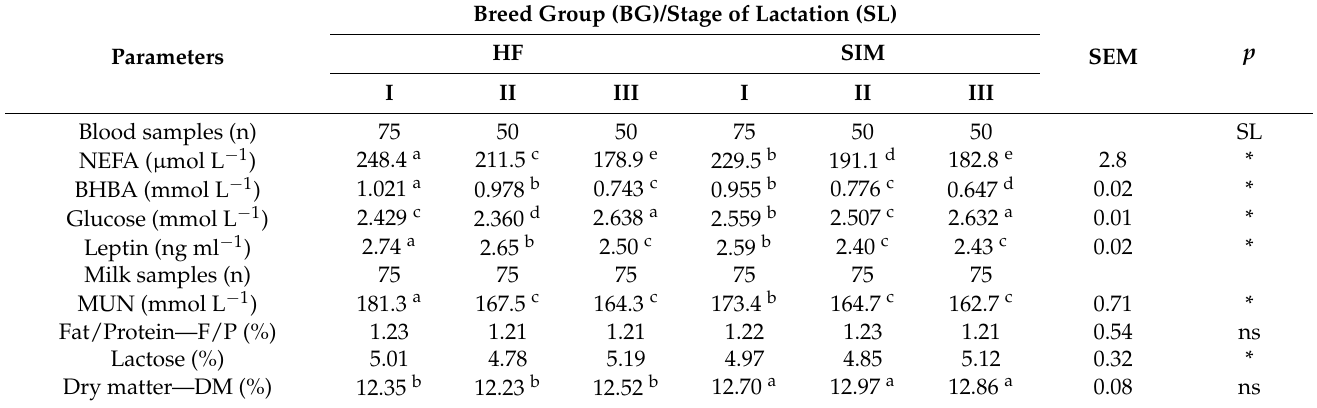
Table 4. Parameters of energy metabolism and contents of milk components depending on the breed group and stage of lactation.